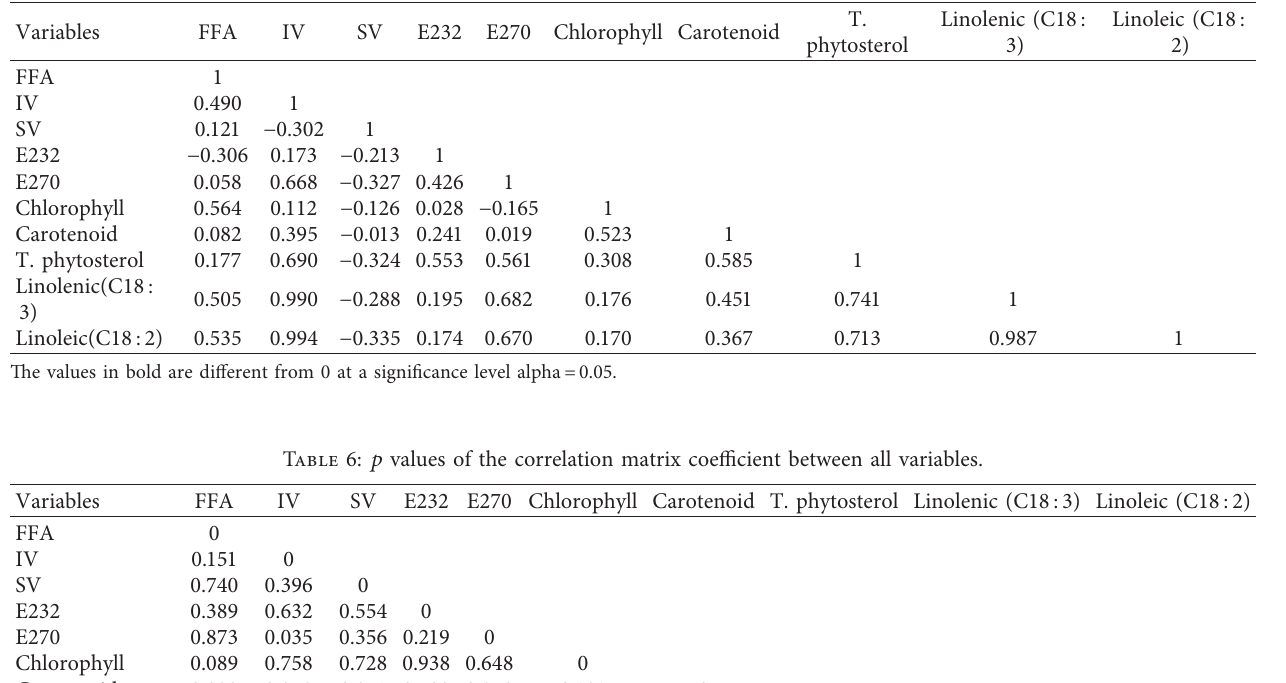
Figure 3: Total phytosterol content of the studied Table 5: Pearson’s correlation matrix coefficient between the variables: quality parameters (FFA, IV, SV, E232, and E270), chlorophyll, carotenoid, total phytosterols, Linolenic (C18:3), and Linoleic (C18:2) acids of the different samples of POOs.